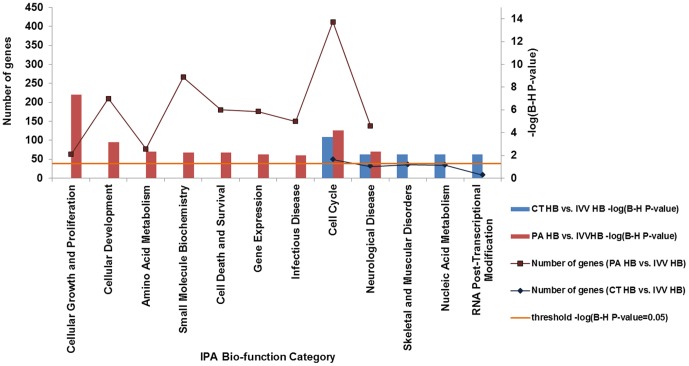
Altered biological function categories in PA and CT-derived HB.Bar chart shows the significantly altered biological function categories in IPA biological function (bio-function) analysis. Major Y axis on the left shows the number of differentially expressed genes that involved in the biological function category. Secondary Y axis on the right shows the significance (-log (B-H P-value)) of the altered biological function category. The orange line shows the significance threshold of cut off of -log (B-H P-value = 0.05).